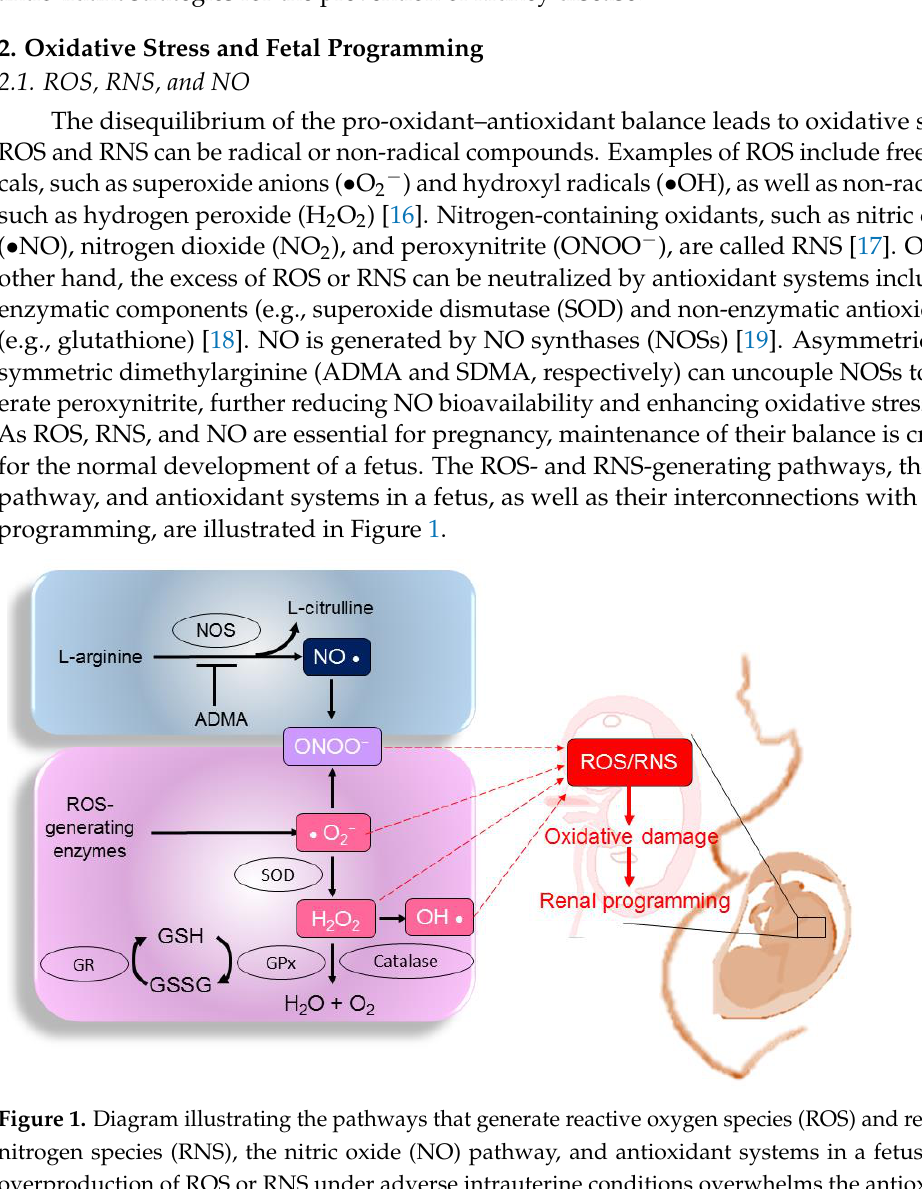
Figure 1. Diagram illustrating the pathways that generate reactive oxygen species (ROS) and reac- tive nitrogen species (RNS), the nitric oxide (NO) pathway, and antioxidant systems in a fetus. The overproduction of ROS or RNS under adverse intrauterine conditions overwhelms the antioxidant system, resulting in oxidative damage and, thereby, compromising renal development. NOS: